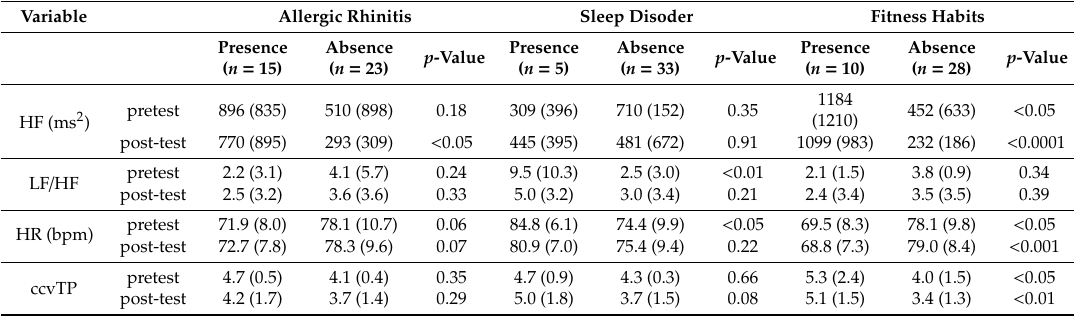
Table 5. Mean pretest and post-test heart rate variation by condition, allergic rhinitis, sleep disorder and fitness